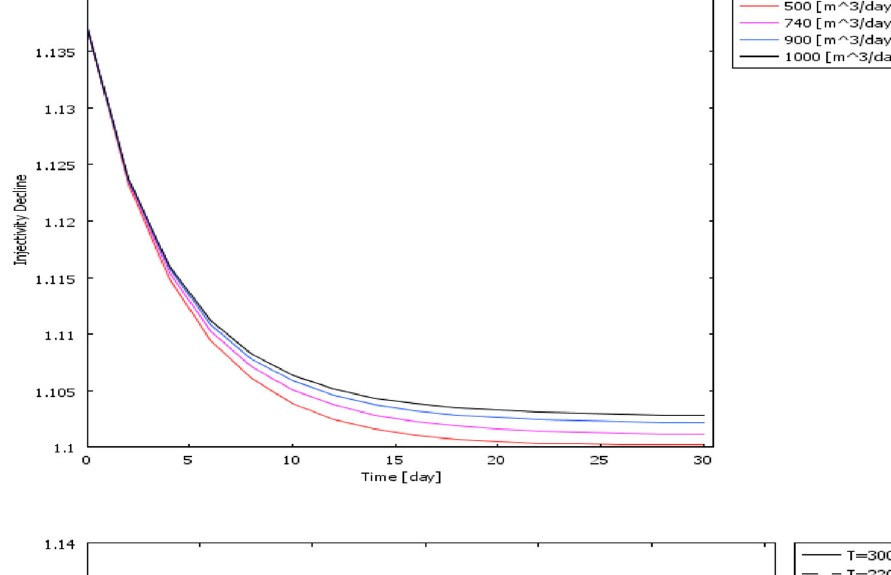
Fig. 18 Injectivity with time at different